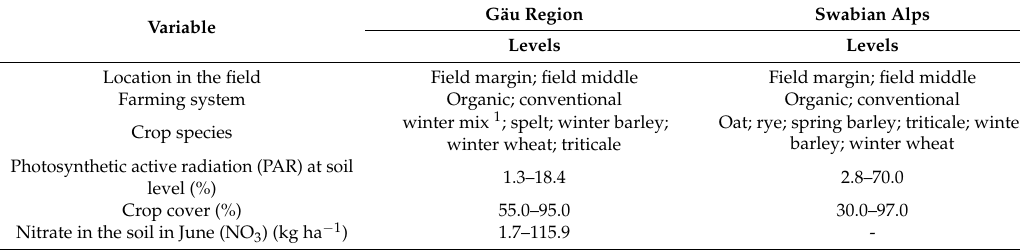
Table 1. Levels and ranges of categorical and metric variables assessed by a farmer survey in the Gäu region and the Swabian Alps.